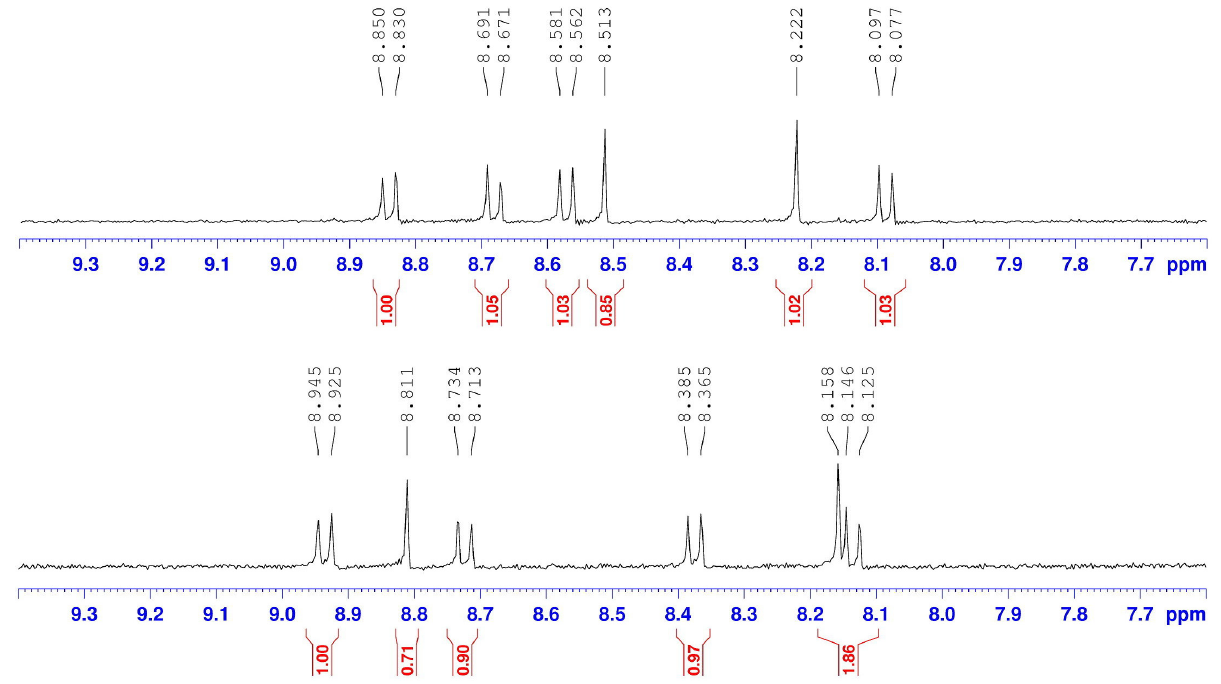
) spectra of 1,6- C (top) and 1,7- C 3